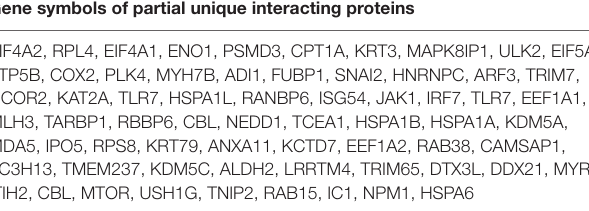
TABLE 2 | List of partial unique PCV2 Cap-interacting host proteins. Gene symbols of partial unique interacting